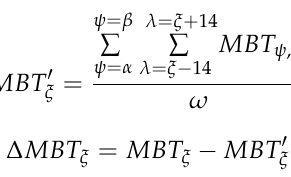
Figure 6. Monthly mean snow depth in the study area.